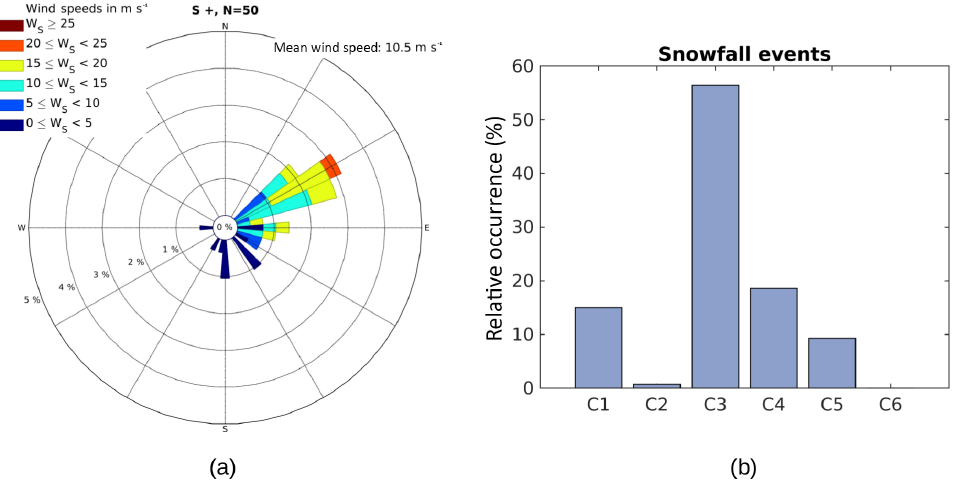
Figure 4. (a) Wind rose showing the hourly speed and direction of the wind recorded by the AWS during snowfall events detected by the MRR. N denotes the total number of snowfall events during the observation period. (b) Frequency of occurrence of the circulation patterns depicted in Fig. 3 for snowfall events detected by the